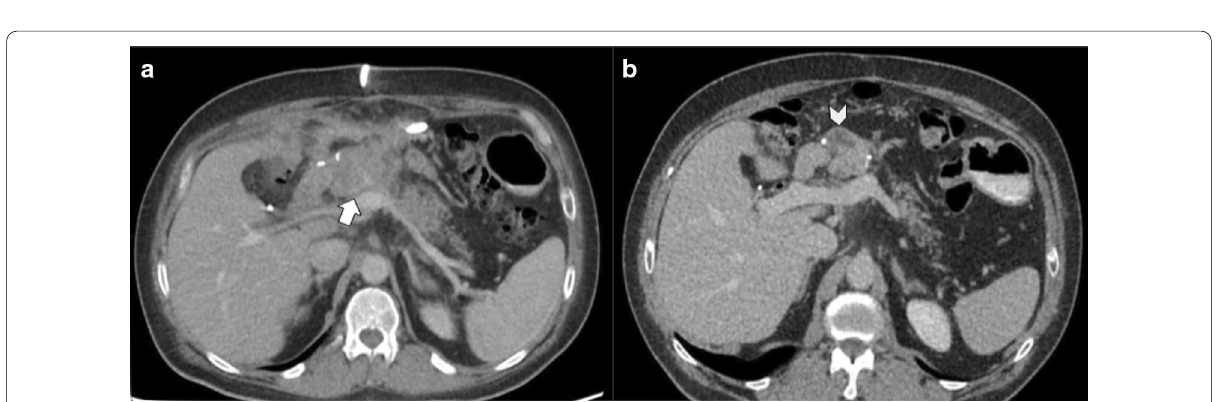
Fig. 9 Collapsed loop versus Tumor recurrence. CT challenge. 58-year-old male patient with history of pancreaticoduodenectomy due to periampullary tumor. Control CT scans. ( a ) Heterogeneous, ill-defined image near pancreaticojejunostomy (big arrow) with peripheral fat stranding and contrast enhancement is seen after three months from surgery. No clinical symptoms or biological marker elevation were present. ( b ) 18 months CT scan control revealed total fat stranding resolution and demonstrated that the ill-defined enhancing image was due to a collapsed loop, which appears mild distended with normal fluid contain